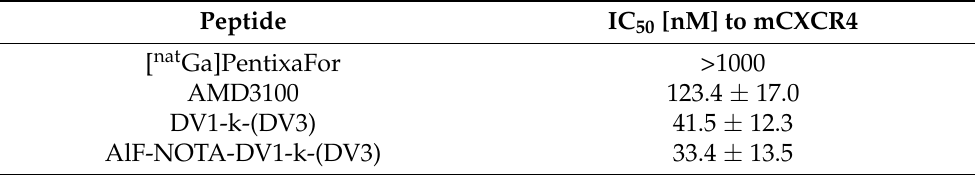
Table 2. Binding affinities (IC 50 in nM) of [ nat Ga]PentixaFor, AMD3100, DV1-k-(DV3) and AlF-